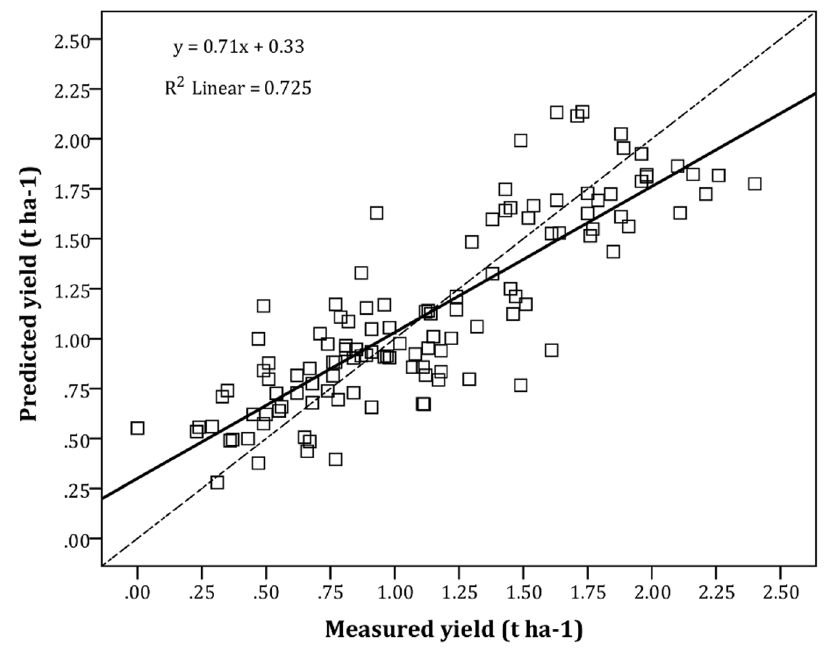
Figure 4. Relationship between measured and predicted Arabica coffee yields – cross validation using ordinary kriging (Predicted Arabica coffee yield index – CYI (t ha 2 1 ) = 0.71x + 0.33; Mean Prediction Error – MPE = 0.0187; Root Mean Square Prediction Error – RMSE = 0.278; Root Mean Square Standardized Prediction Error – RMSSE =0.99; Mean Standardized Prediction Error - MSE = 0.036; Coefficient of determination – R 2 =0.73; Average Standard Error –Avg. SE=0.291; Sample points, n=121).